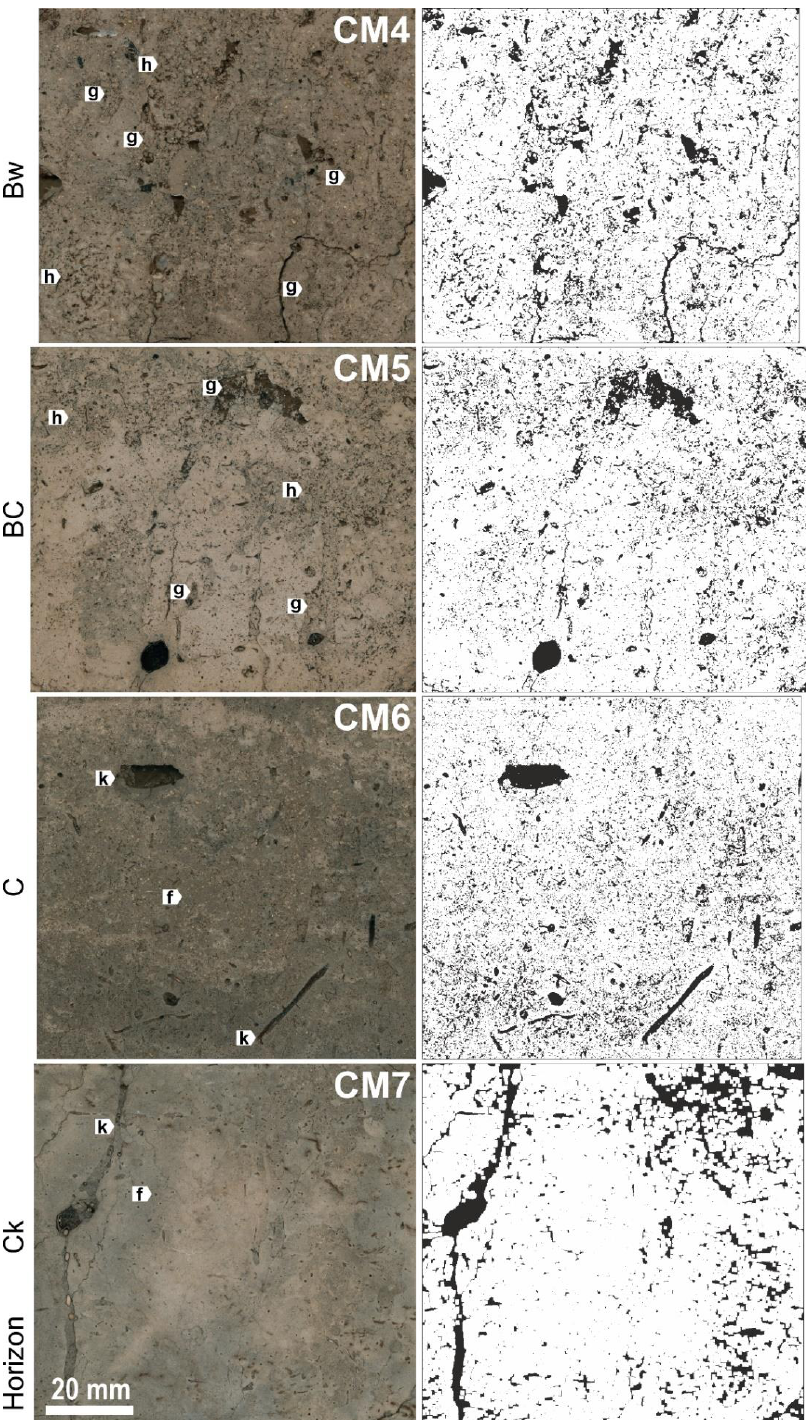
Figure 2. Representative images of the Cambisol macrostructure ( left panel ) and the corresponding binary images ( right panel ), wherein the pores are marked with black. Characteristic features of the Cambisol structure: a–not fully decayed and loosely arranged plant remnants; b–crumbs in a continuous pore space; c–roots and plant remnants; d–sub-angular blocks separated by planes; e–biogenic channels; f–vughs; g–bioturbations visible as channels filled with aggregates; h–zones of aggregate structure; and k–zoogenic